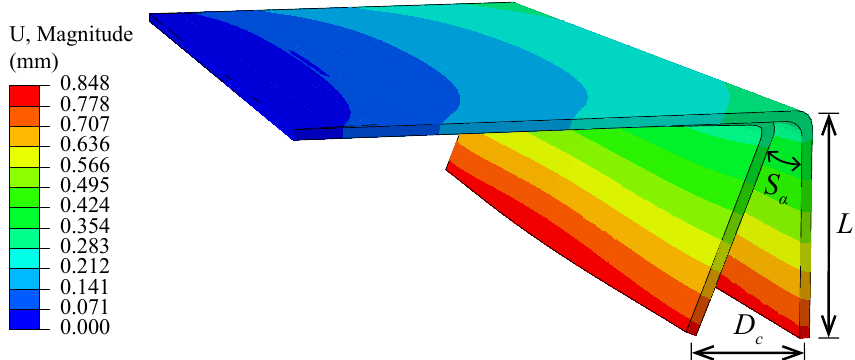
Figure 6. The predicted curing deformation of the composites with layup [ 0/90 ] 4S .